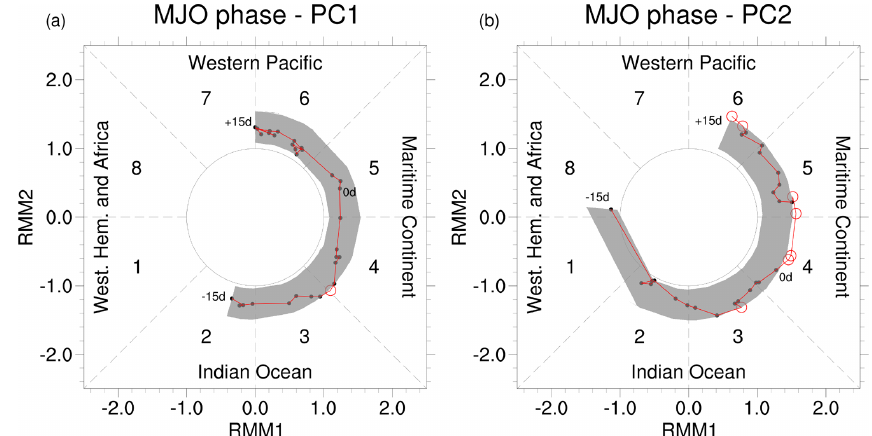
Figure 7. Time series of median amplitude and corresponding phase of Real-time Multivariate (RMM) MJO index values for the set of (a) CRWP1 and (b) CRWP2 events, evaluated between t max − 15d and t max + 15d (connected by red line). The values between the 10th and 90th percentile of the bootstrapped MJO amplitude distribution are also depicted (gray region): empty red dots indicate amplitudes exceeding the 95th percentile of the null